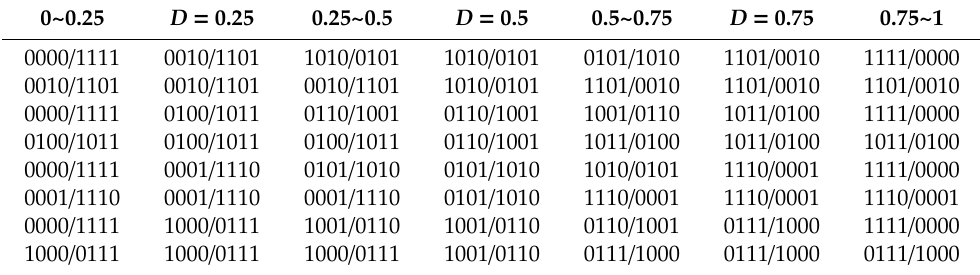
Figure 5. The key waveform of the four arms mixed. ( a ) Mode 0.5 < D < 0.75, ( b ) Mode 0.25 < D < 0.5.